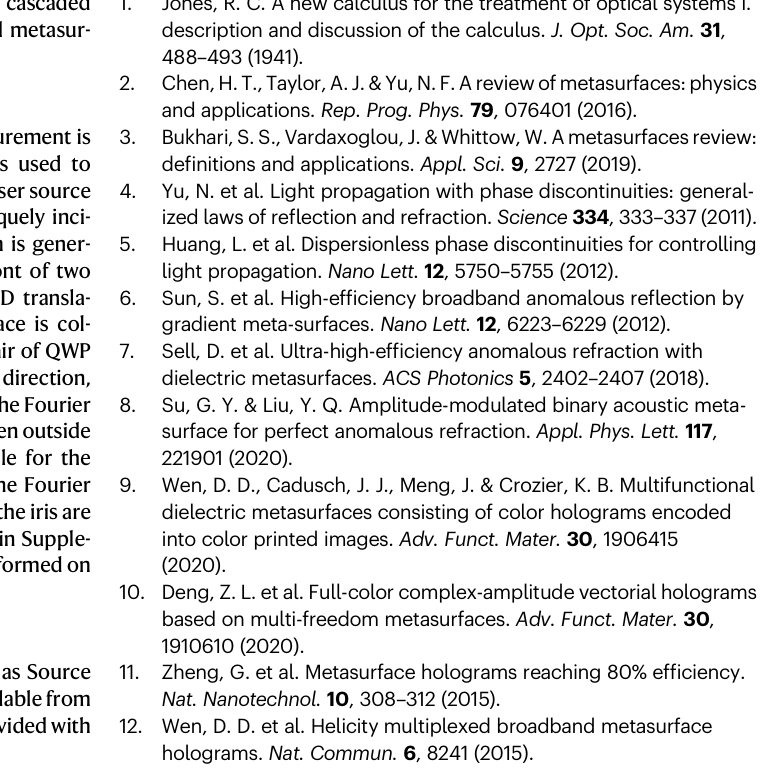
with rotation angles of ϕ = 0°( fi rst row), 90°(second row), 180°(third row) and 270°(fourth row). The holographic images are designed at 1500 μ m above the second layer in the glass substrate. The incident and analyzed polarizations are indicatedatleftsideandrightside,respectively.Allpanelssharethesamescalebar in the lower left